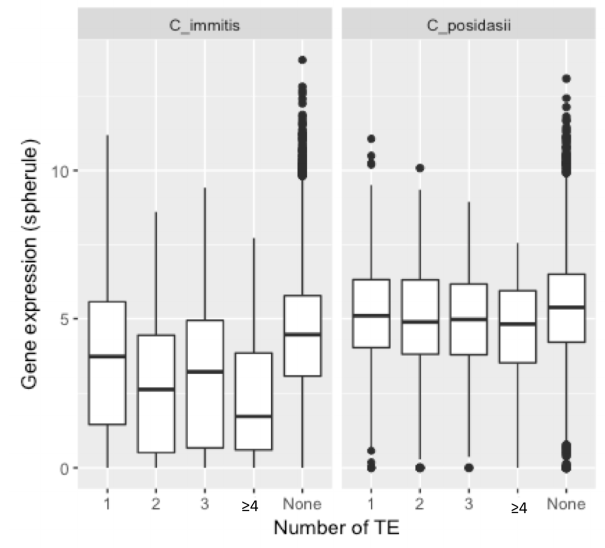
Figure 4. Expression (median values log 2 FPKM) of C. immitis and C. posadasii loci within 1 kB of one or more TE. The p -values for gene expression of all C. immitis groups flanked by at least one TE compared to control expression levels (“None”) are less than 1 × 10 − 4 . The p -values of C. posadasii gene expression of genes flanked by at least two TEs is 7 × 10 − 3 compared to the control (“None”). The remaining C. posadasii gene expression values are not significantly lower than the control value.